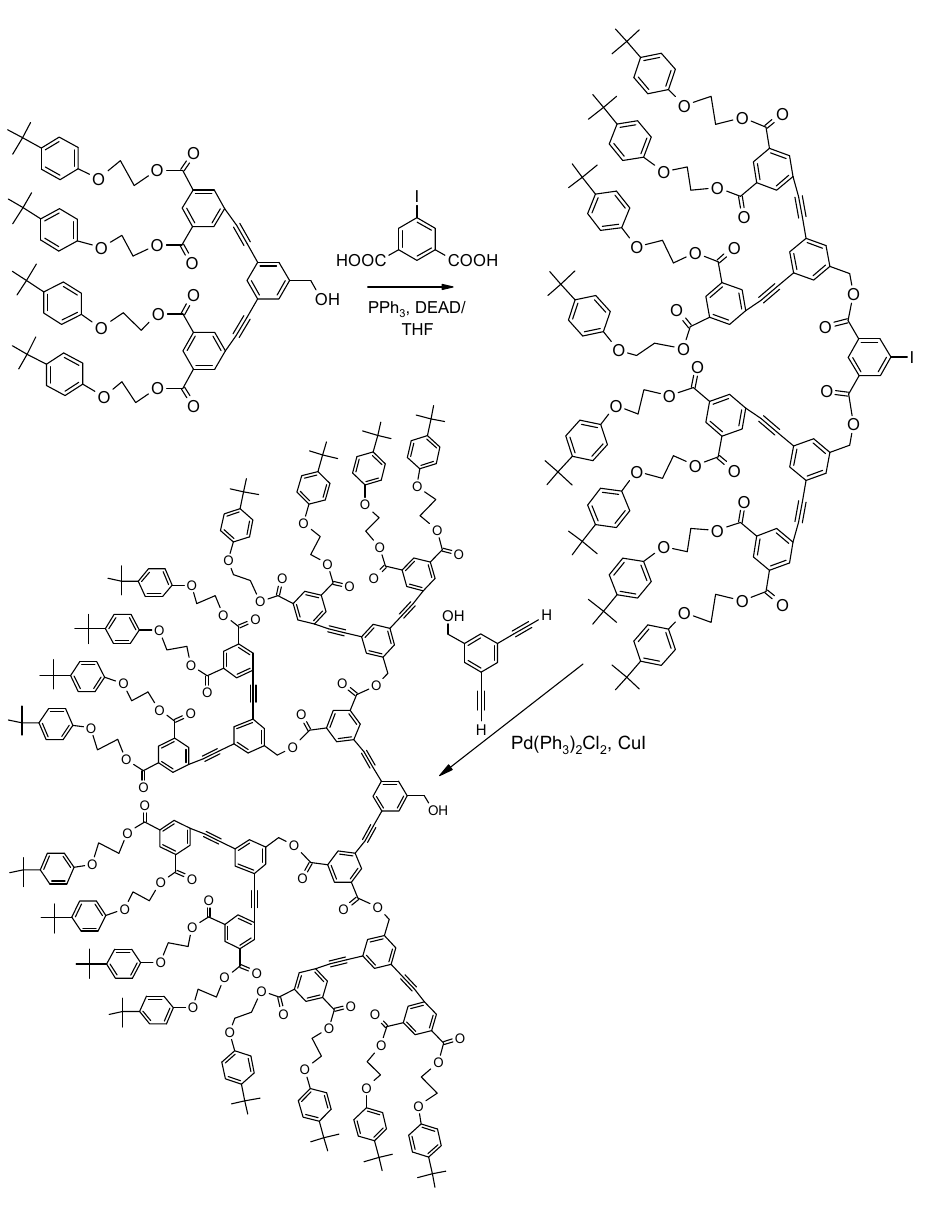
Scheme 5. Formation of an alternating polyester dendrimer